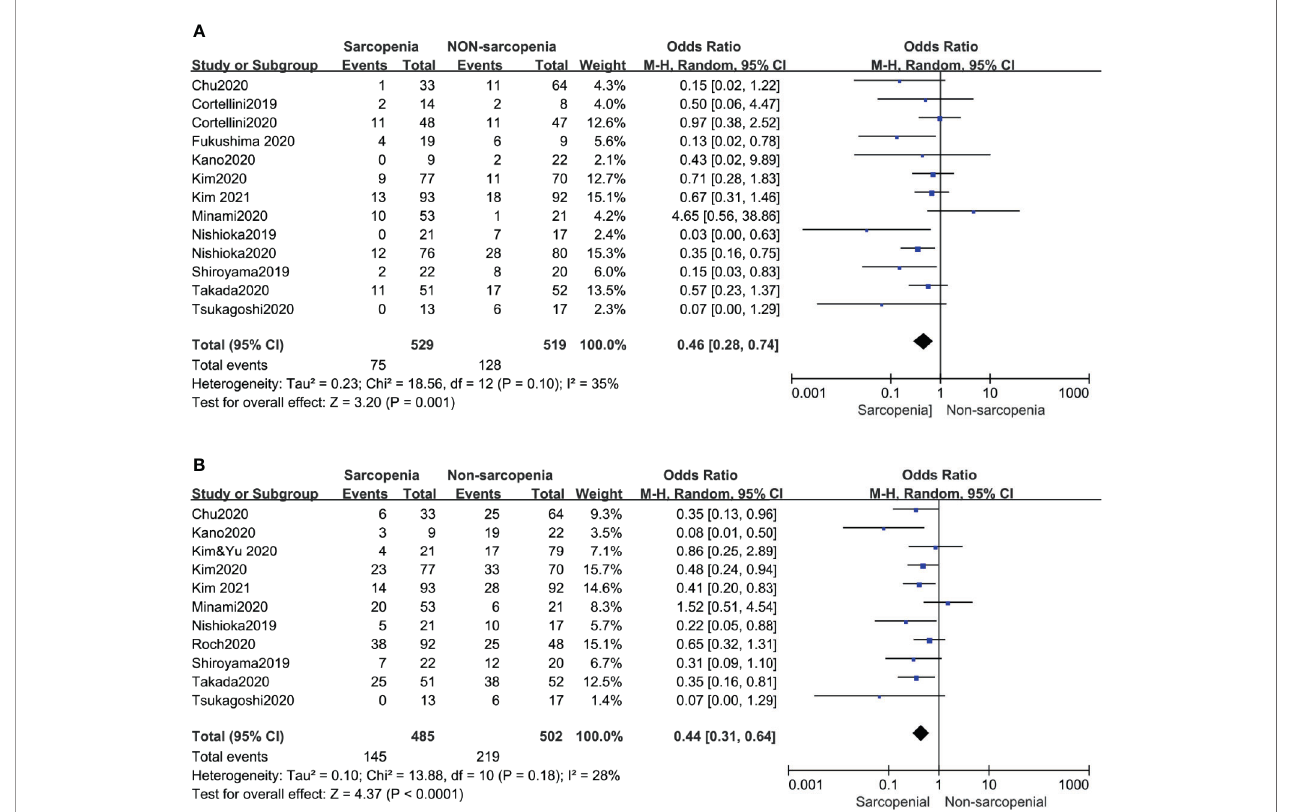
FIGURE 4 | Forest plot of impact of sarcopenia on tumor response. (A) Sarcopenia and ORR, (B) Sarcopenia and DCR.